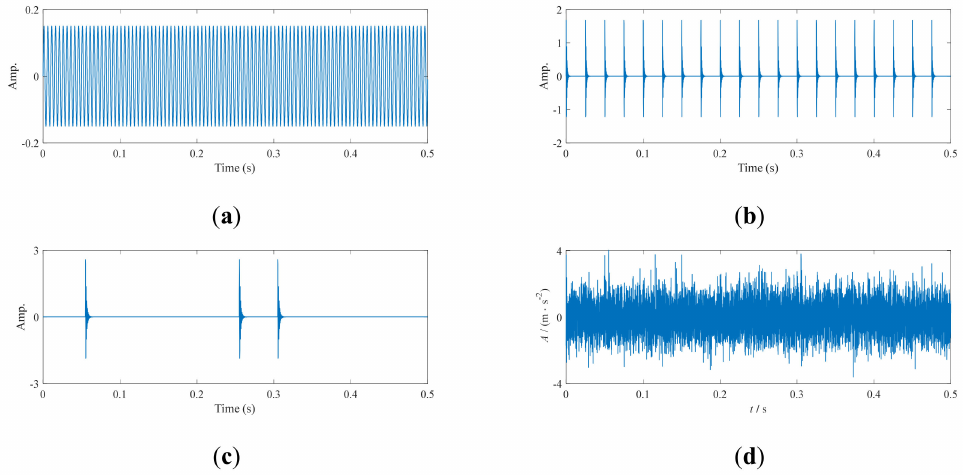
Figure 3. Simulation signal: ( a ) harmonic component y 1 , ( b ) periodic impulse component y 2 , ( c ) interface impulse component y 3 , and ( d ) composite signal y .